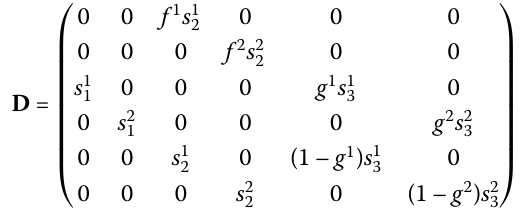
model presented in [9], locally the population is considered structured into three classes corresponding to juveniles and two adult stages. Adults that reproduce at the end of an interval of time do not reproduce at the end of the following one. A fraction of those not having reproduced do so at the end of the following interval. Thus, adults are classified into those reproducing at the end of the time interval, active adults, and those adults who do not, inactive adults. The aim of this consideration is analyzing the reproductive synchrony of